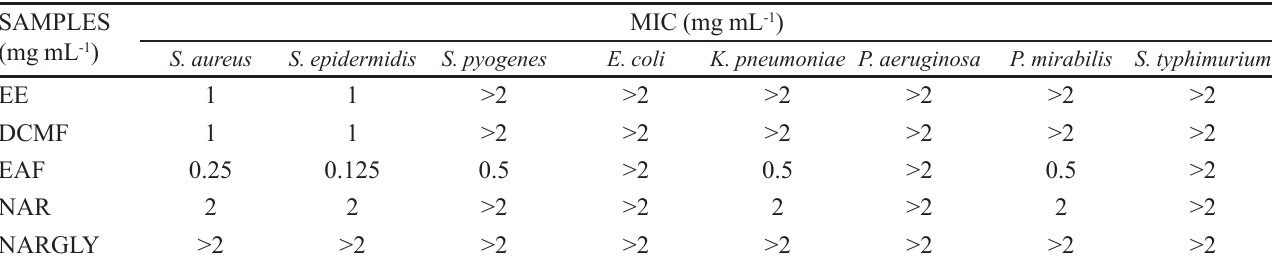
TABLE II - Antibacterial activity, by determination of MIC, of extracts, fractions and isolated substances from the flowers of Acacia podalyriifolia A. Cunn. ex G.